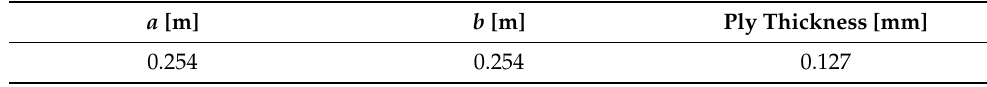
Figure 10. Boundary conditions of the laminated plates. C and F stand for clamped and free edges respectively. Pressure P is exerted uniformly on the laminate yz plane. Table 1. Geometrical dimensions of the laminated